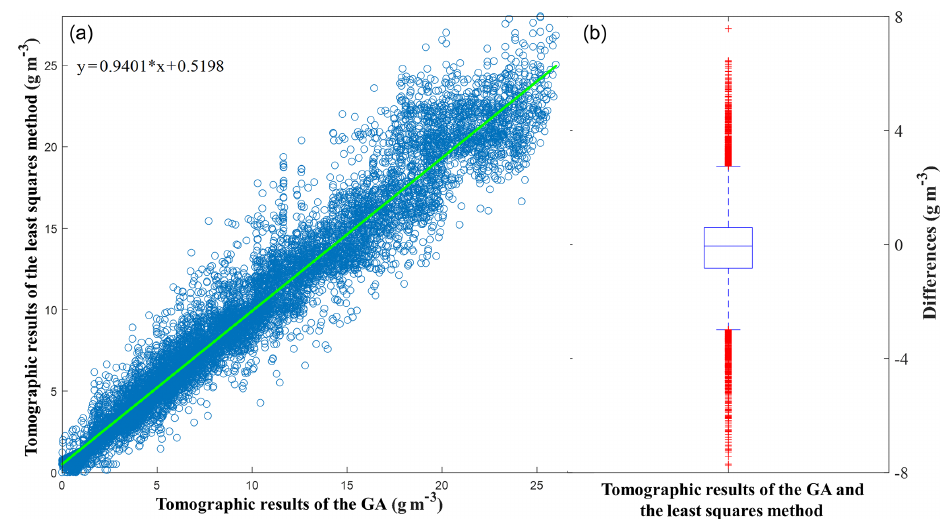
Figure 13. Regression (a) and boxplot (b) for tomographic results (WVD) of the GA and the least squares